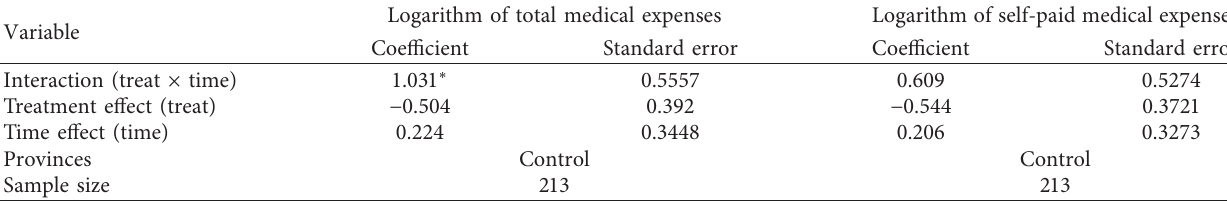
Table 5: Regression results of fixed effect